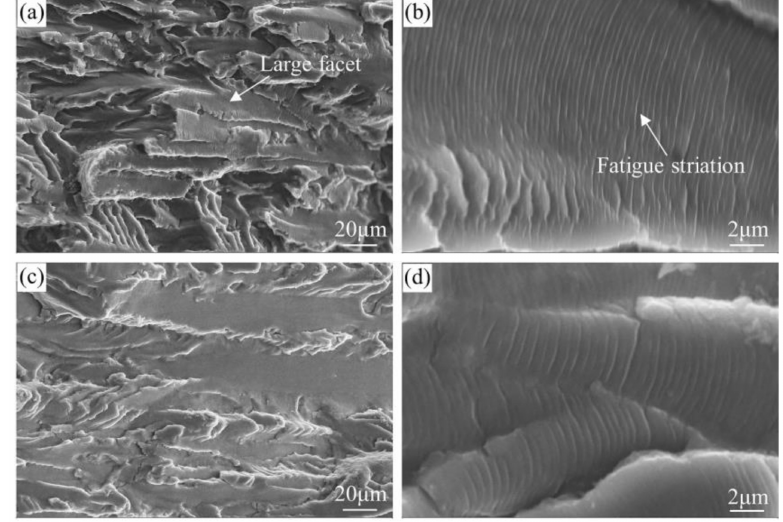
Figure 11. SEM fractographs characterizing the fatigue fracture surfaces of the ( a , b ) T574 and ( c , d ) T573 alloy at ∆ K of about 15 MPa · m 1 / 2